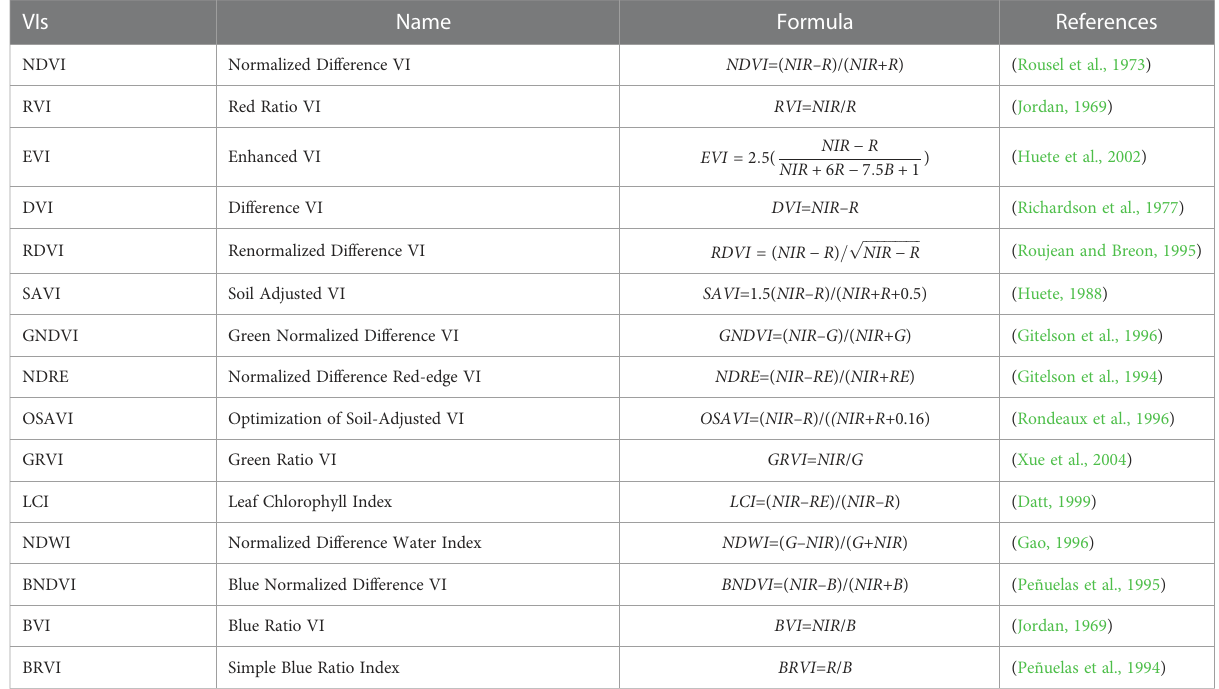
TABLE 1 Vegetation indices, equations, and sources used in the study.